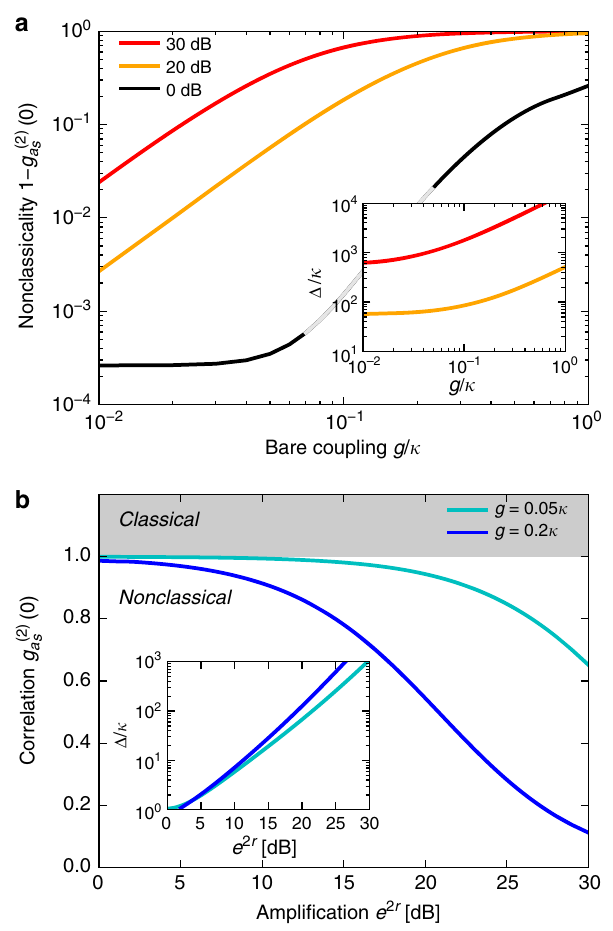
Figure 3 | Nonclassical photon intensity correlations. Intensity correlation ^ a y ^ a s ^ a s i = h ^ a y ^ a s i 2 , for a mechanical parametric drive 0 ð Þ¼h ^ a y function g ð 2 Þ a s s s s yielding the optomechanical interaction ^ H SRP (cf. equation (2)), and for a weak coherent probe tone applied to the cavities. In a , g ð 2 Þ a ð 0 Þ is plotted as a s function of g for different values of the amplification factor e 2 r ; in b it is plotted as a function of e 2 r for a fixed value of g . For each value of g and r , the probe frequency and the parametric-drive detuning D are optimized to minimize g ð 2 Þ a ð 0 Þ ( D is plotted in insets). The amplitude of the weak probe is s kept fixed. ( a ) The violation of the classical bound g ð 2 Þ a ð 0 Þ (cid:11) 1 is enhanced s in our scheme: the presence of the mechanical parametric drive leads to significant suppression of g ð 2 Þ a ð 0 Þ for experimentally accessible couplings s g (cid:7) 0 : 01 k . ( b ) Mechanical parametric driving brings the optical field deep into the nonclassical region even for g ¼ 0.05 k , leading to non-Gaussian optical fields (Supplementary Fig. 2). For these results, dissipative squeezing is used, with a damping rate g b ¼ 0.001 k . picture (cf. equation (6)), the state with two symmetric photons (|2, 0, 0 i ) and the corresponding first phonon sideband ð 2 ; 0 ; 1 j i¼ ^ b y 2 ; 0 ; 0 j iÞ are equally detuned from the one-photon state (|1, 0, 0 i ). The intensity correlations are described to a good (cid:9) (cid:10) (cid:7) . Increasing the 0 ð Þ (cid:8) 1 1 þ 0 : 8 ~ g = k ð Þ 2 approximation by g ð 2 Þ a s